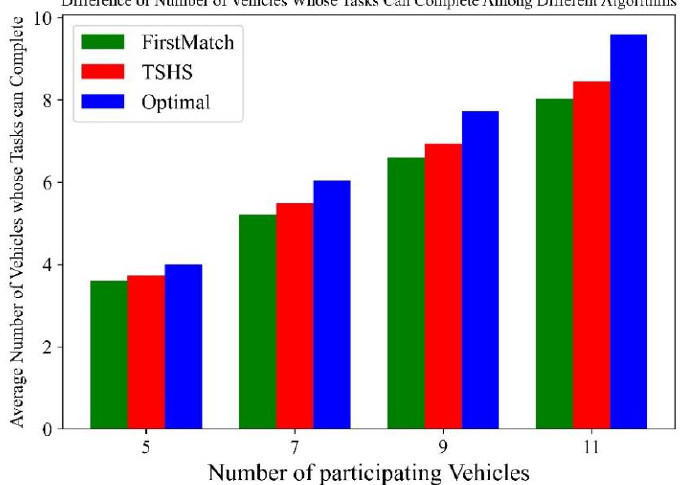
Figure 9. Differences in the number of vehicles whose tasks can be completed among different al- gorithms under different numbers of participating vehicles. algorithms under different numbers of participating